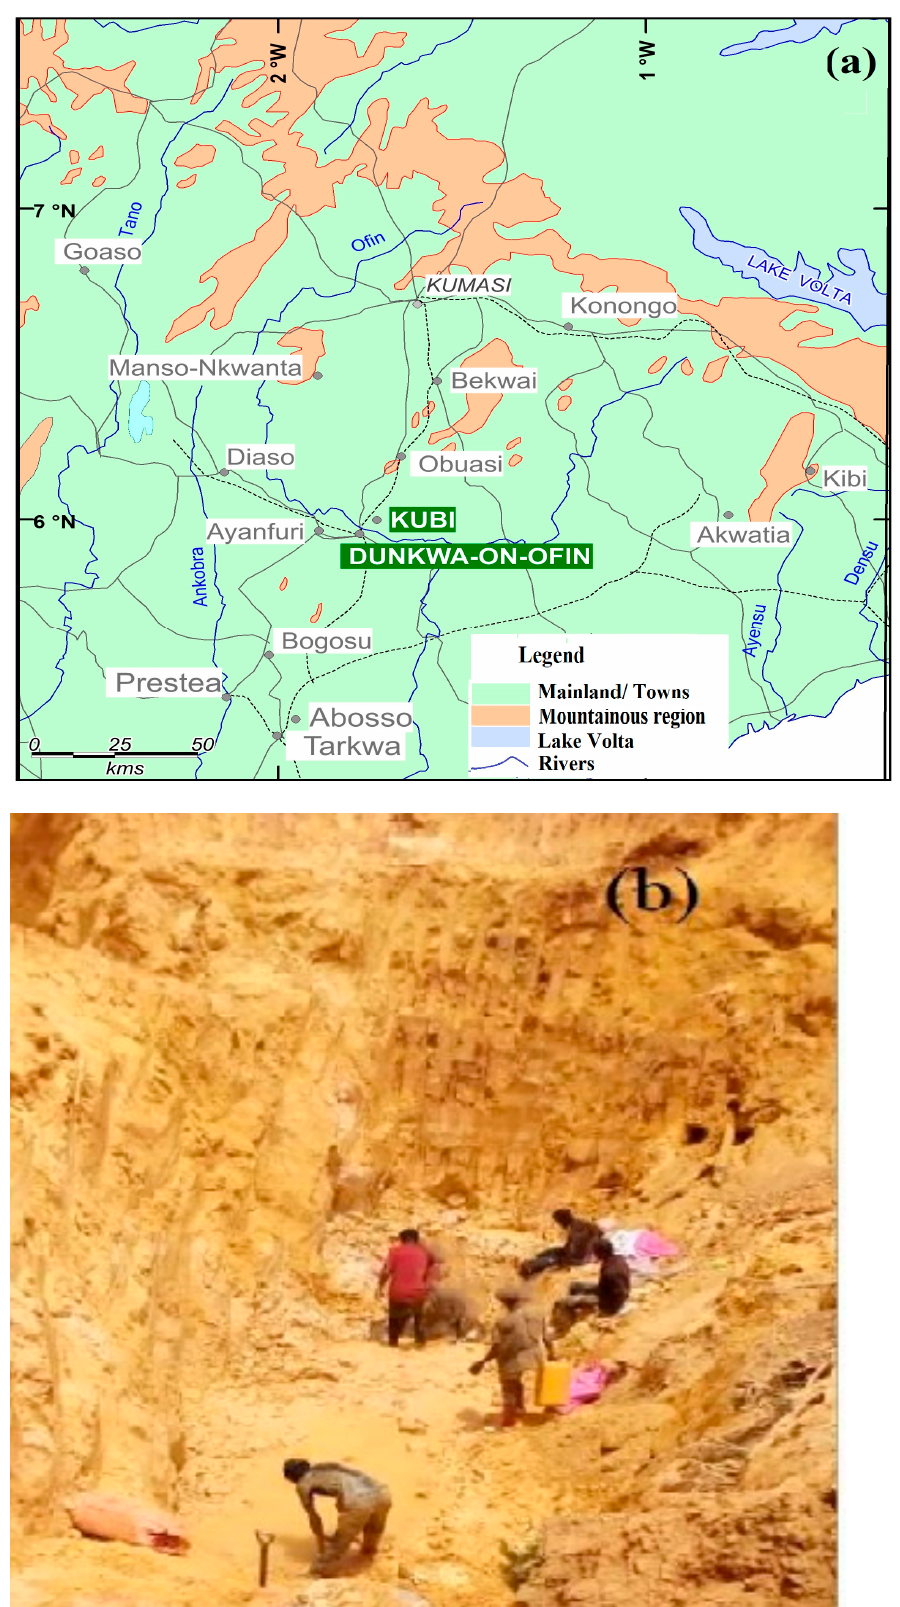
Figure 1. ( a ) Map of Kubi village and surrounding Townships and ( b ) Picture of sampling area of “Kubi Gold Barbados”, Dunkwa-on-Offin. (Map and photo by G.K. Nzulu).